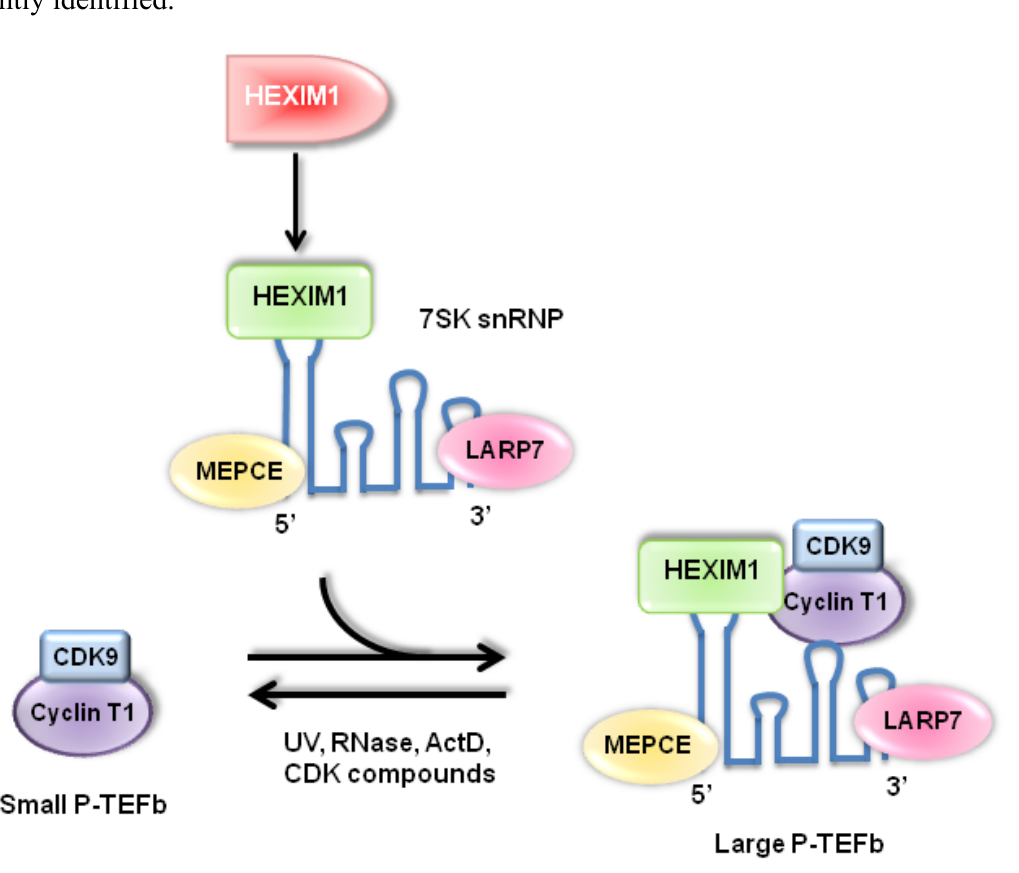
Figure 1. Two P-TEFb complexes are found in cells. The small P-TEFb complex, composed of cyclin T1 and CDK9, is the active form of P-TEFb. The kinase activity of P-TEFb is inhibited when P-TEFb interacts with HEXIM1 and 7SK snRNA to form the large P-TEFb complex. Two other components of the large complex, MEPCE and LARP7, have been recently